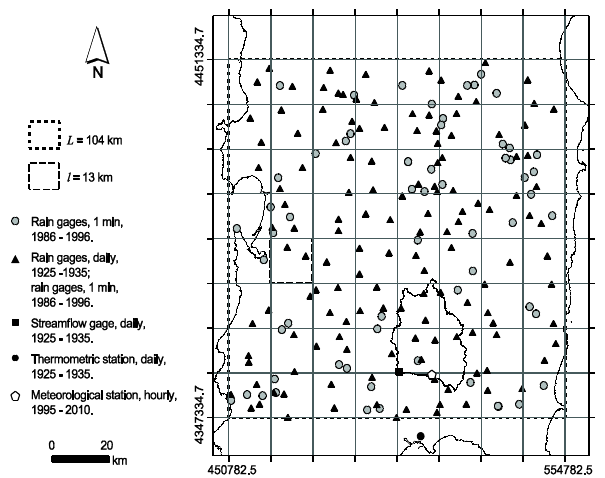
Fig. 3. Location of rain gages, meteorological stations and stream- flow gage. The square with a dashed line is the coarse domain L × L ( L = 104km) containing the fine-scale grid at resolution l × l ( l = 13km) used to calibrate the precipitation downscaling tool. See Table 3 for details.